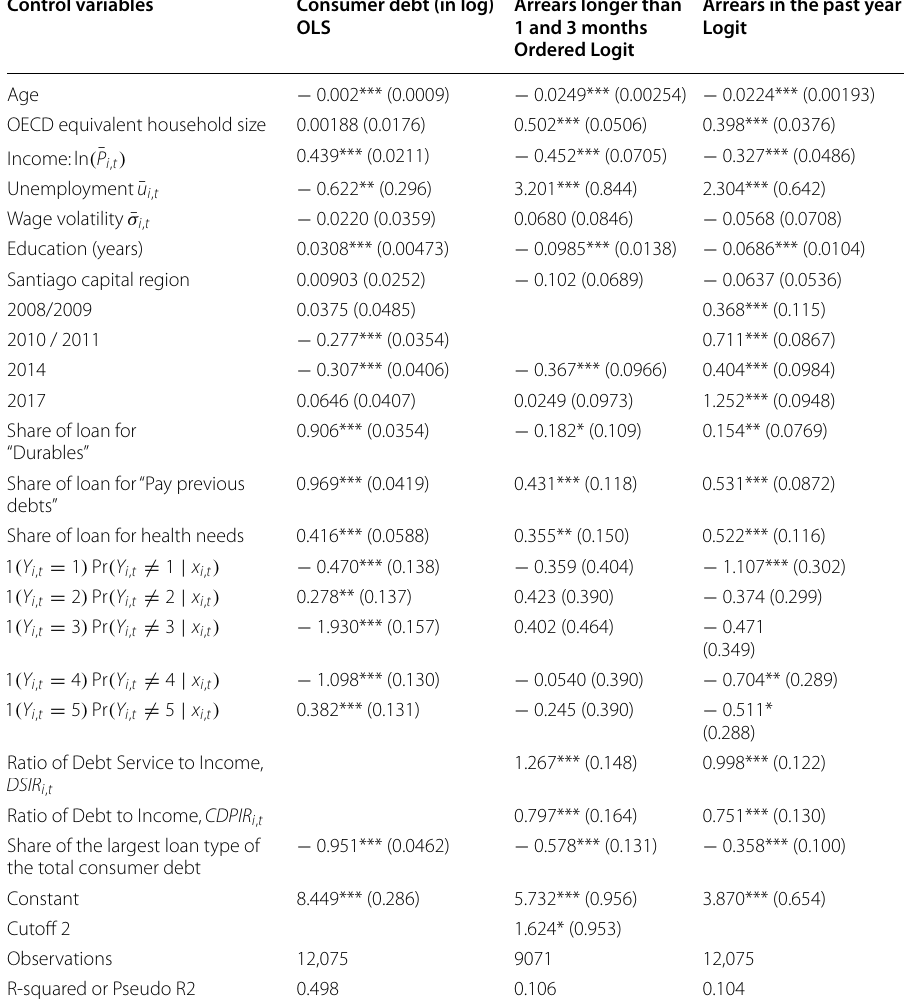
Table 7 Coefficients for the loan amount (in log) and propensity for